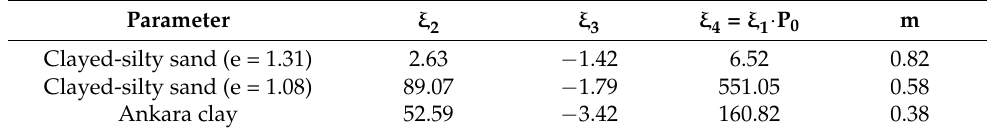
Table 3. Values of the model parameter fitting for the literature